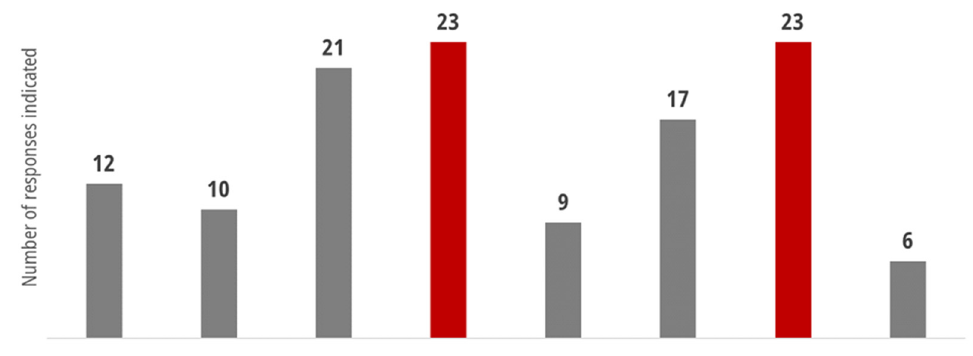
Figure A10. Responses to question (14).